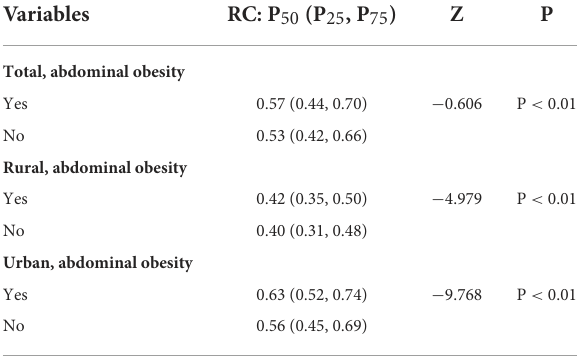
TABLE 3 The univariate analysis of